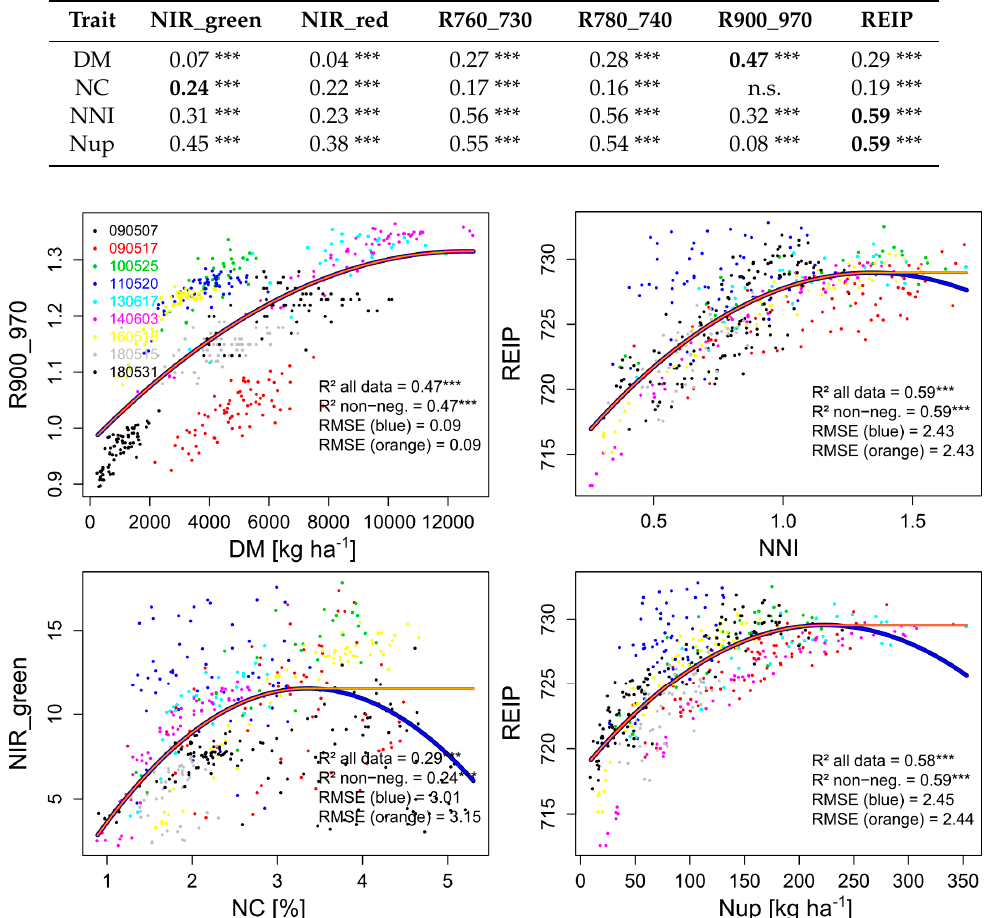
Figure 2. Curves fitted between reference traits and vegetation indices across all measurement dates (year / month / day) for calculating the noise equivalent (Figure 3) for the four reference traits. For each trait, the relationship (***: p < 0.001) of the R 2 -based best index is shown. Fitted values at negative slopes (blue line) were replaced by constant plateau-shaped values (orange line). RMSE values refer to the index values.